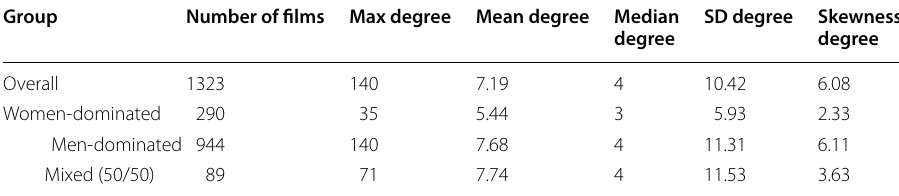
The table displays the descriptive statistics of the degree distribution of 1323 films made by all core creative teams, women- dominated, men-dominated, and mixed (50/50) core creative teams that are connected to 1523 festivals